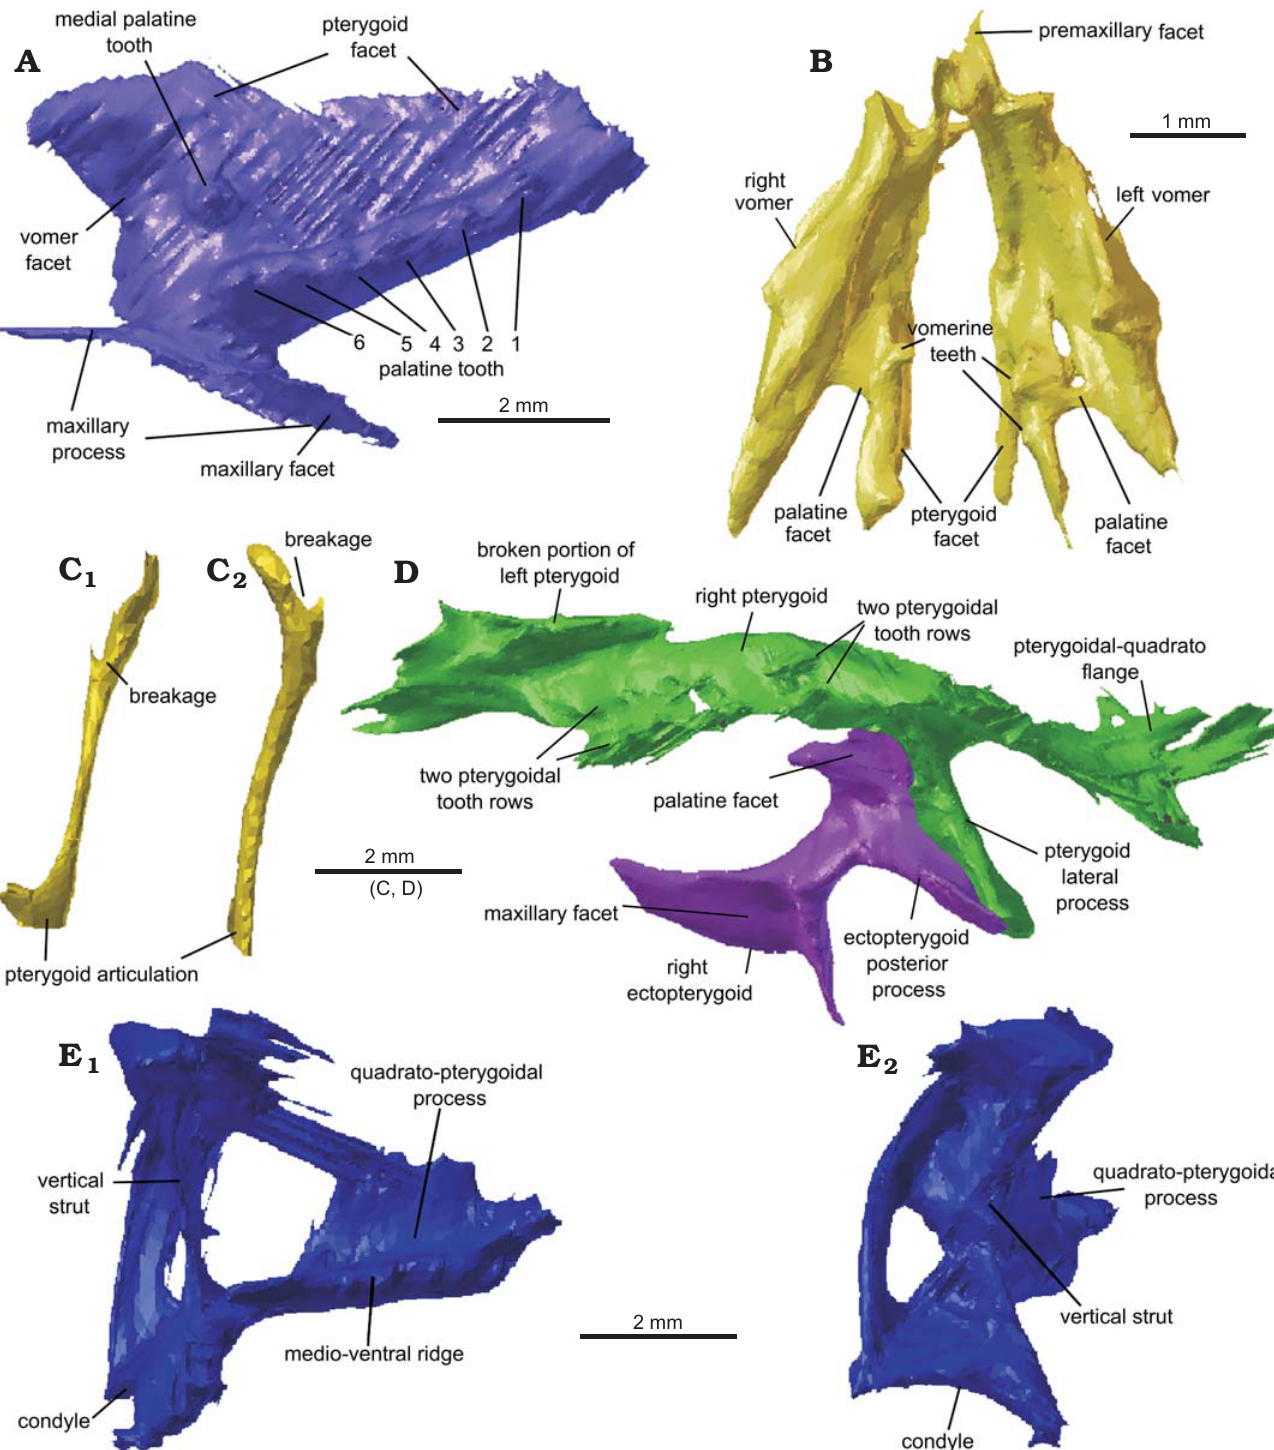
Fig. 8. Cranial bones present in lepidosaur rynchocephalian Clevosaurus cambrica Keeble, Whiteside, and Benton, 2018 (NHMUK PV R37014) from Late Triassic, Pant-y-ffynnon, Wales, UK. A . The right palatine in ventral view. B . The left and right vomers in ventral view. C . The left epipterygoid in lateral (C 1 ) and posterior (C 2 ) views. D . The left pterygoid and ectopterygoid in ventral view. E . The left quadrate in medial (E 1 ) and posterior (E 2 )